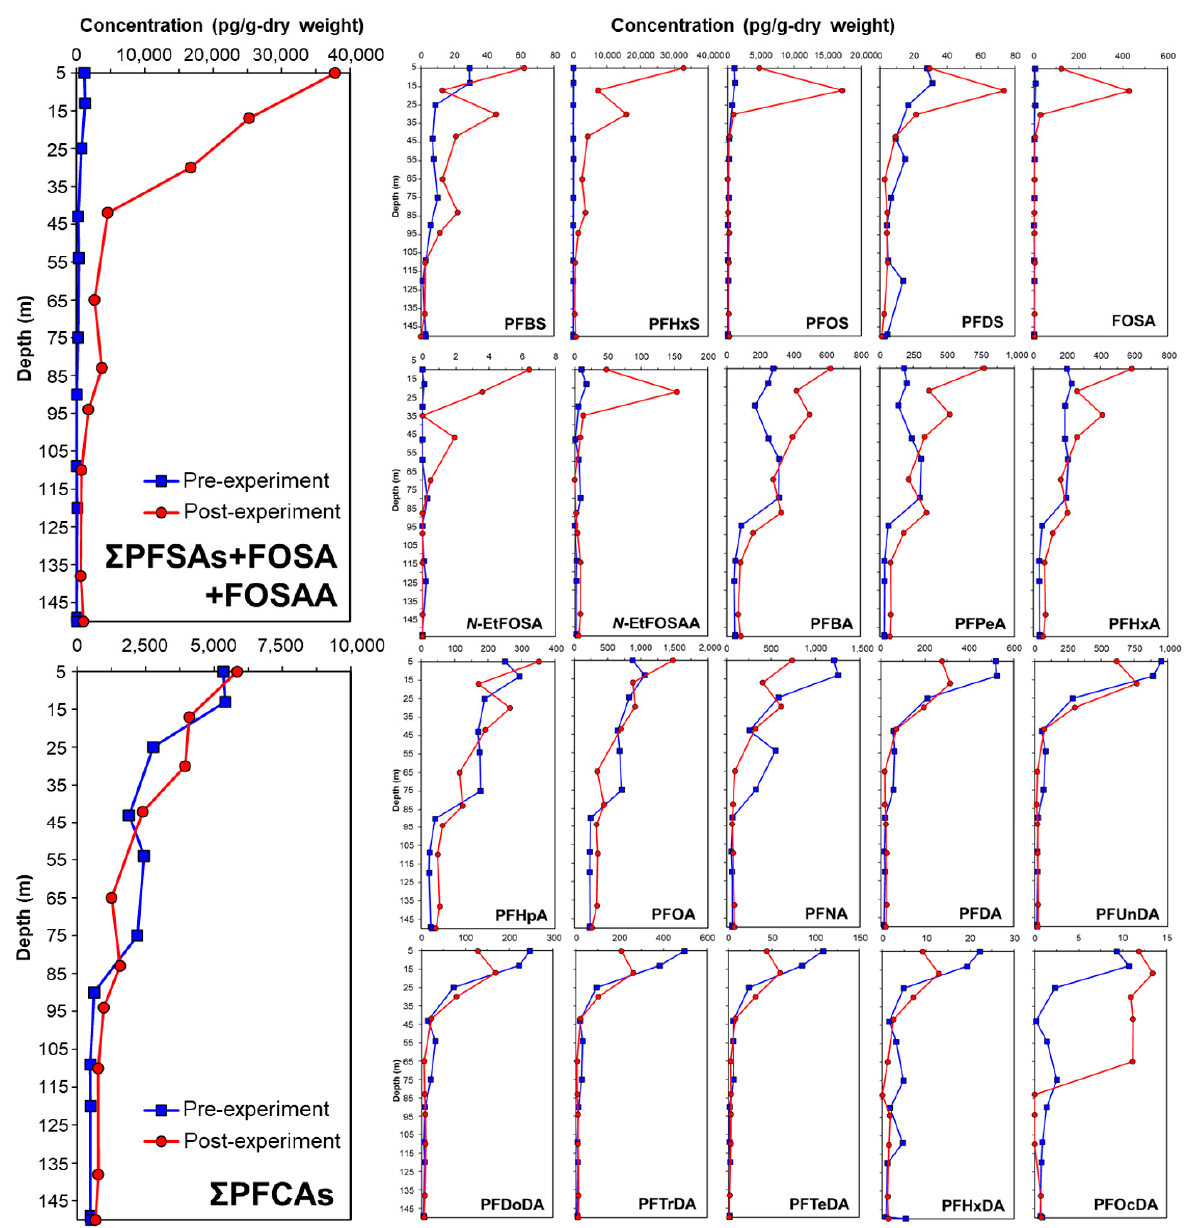
Figure 2. Concentrations (pg/g-dry weight) of PFAS in pre- and post-experimental lysimeter soil core.